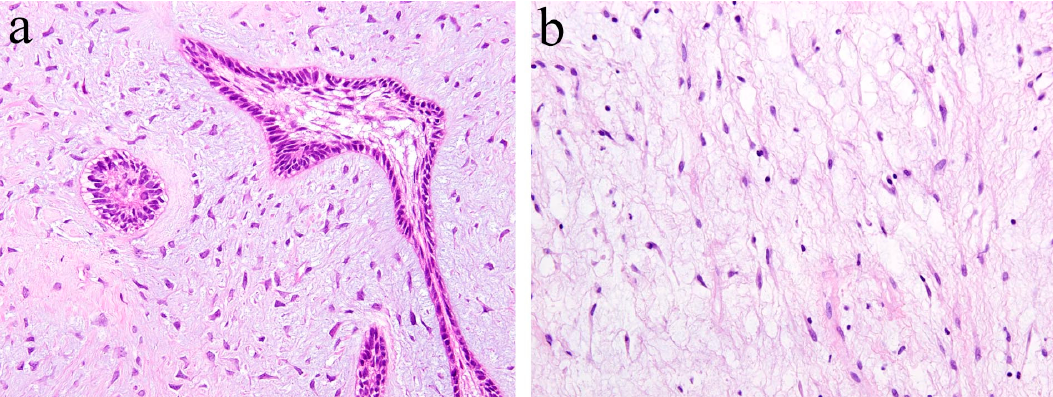
Figure 3. Histopathological features of ( a ) ameloblastic fibroma and ( b ) odontogenic myxoma. HE staining, magnification ×100.